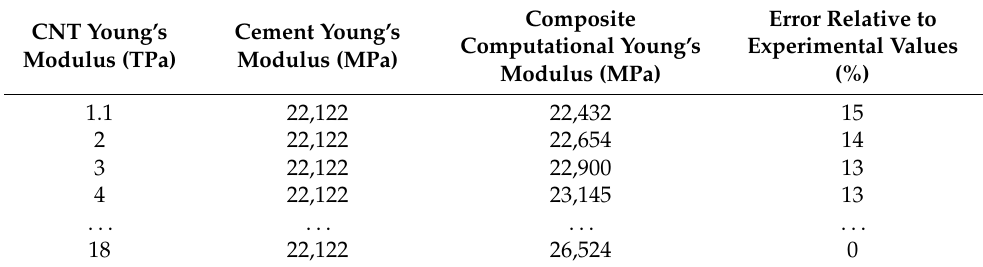
Table 6. Computational results for composite Young’s modulus variation considering different CNT Young’s modulus values for a given cement Young’s modulus.